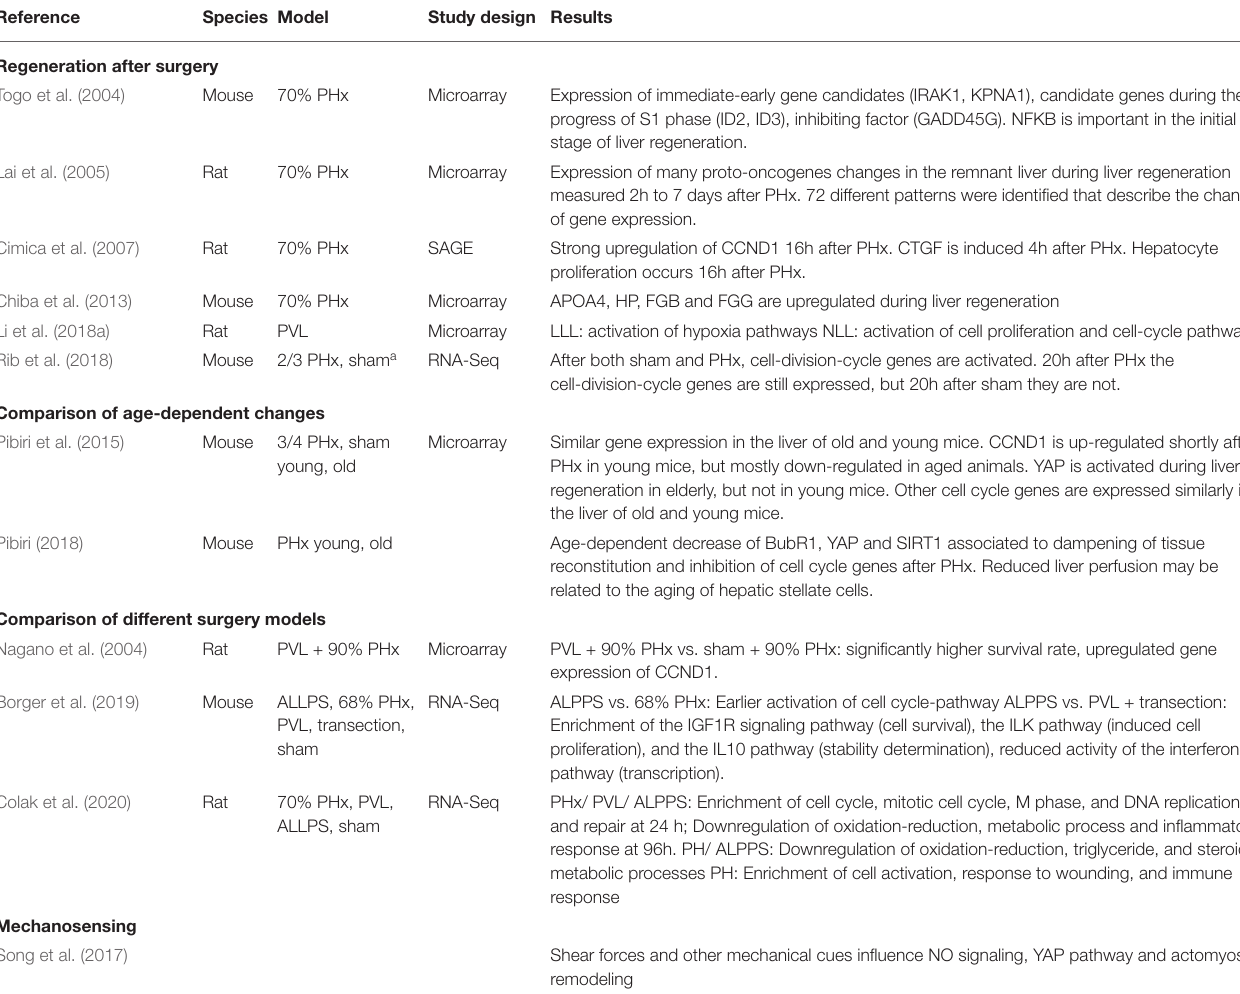
TABLE 6 | Selection of gene expression studies focussing on hepatectomy and liver regeneration.